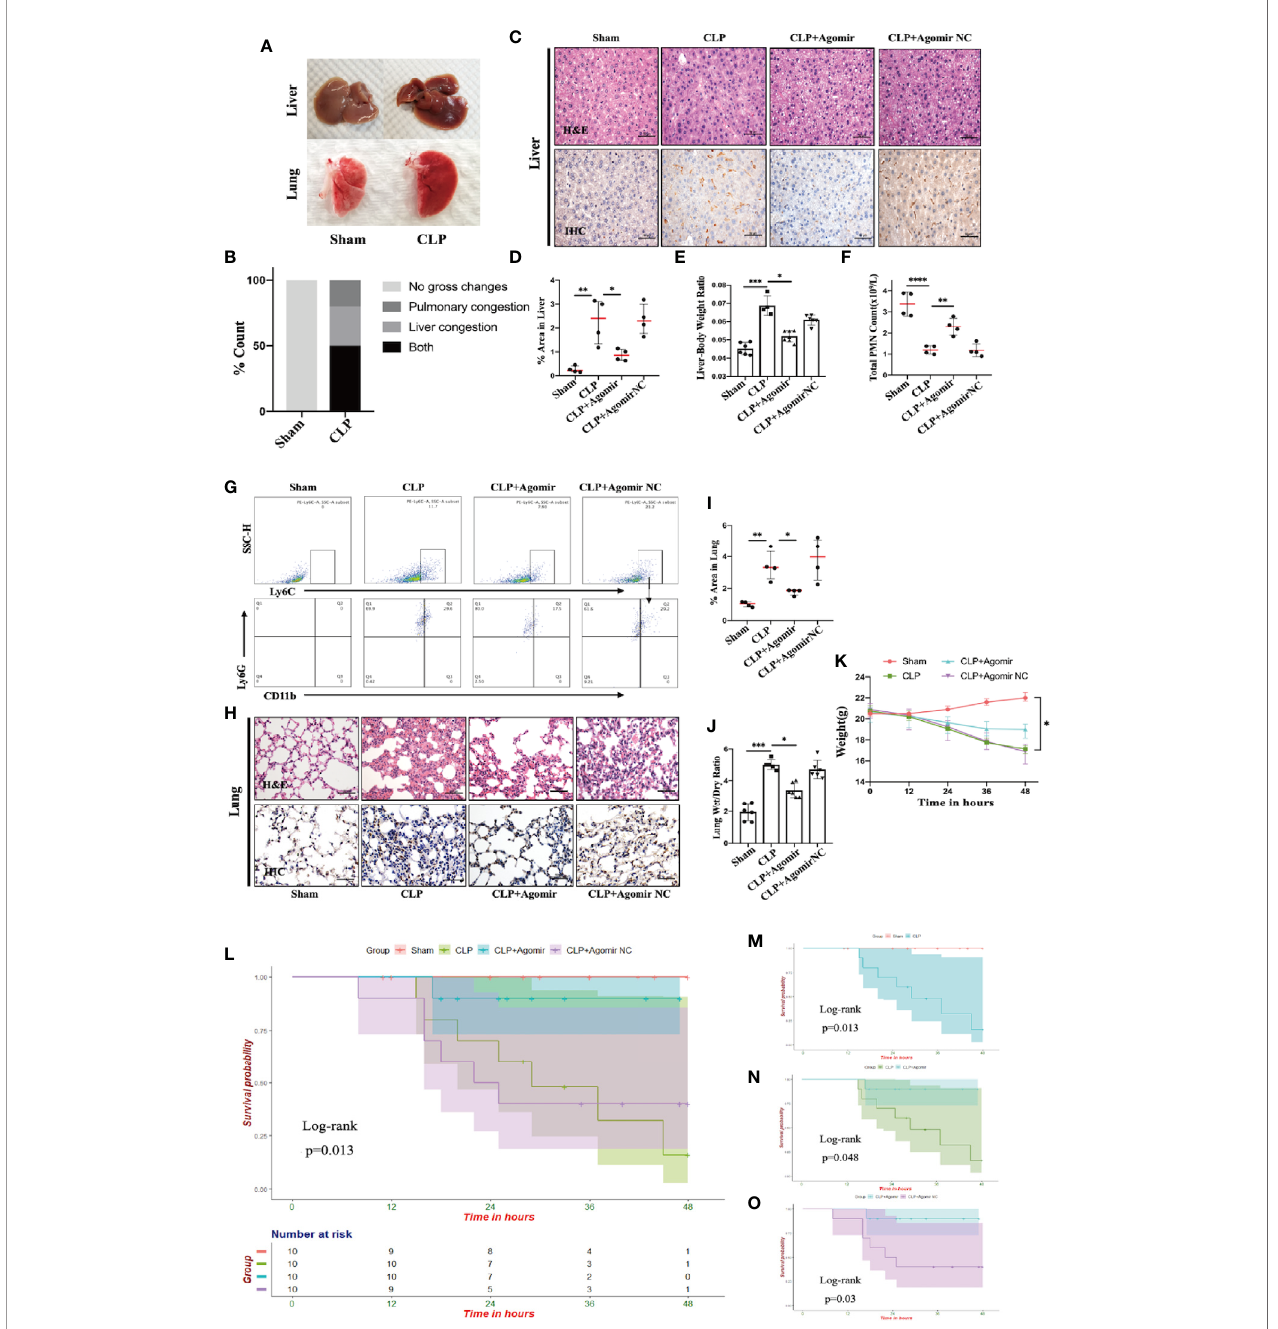
FIGURE 5 | Targeting miR-let-7b alleviates tissueinjury and improves overall survival in CLP murine models. (A, B) Gross pathologic changes in mouse livers and lungs showing pulmonary/liver congestion in sham and CLP-treated mice groups. (C) Histological assessment of livers harvested at 48 hours. Shown are representative H&E stain (upper panel) and IHC images (lower panel). In fi ltratingneutrophils were identi fi ed by CD11b (brown), Scale bars, 50 m m. (D) Area of IHC positive for CD11b expressed as a percentage and assessed in fi ve aleatory images. *P < 0.05; **P < 0.01, one-way ANOVA, n= 4/group. (E) The whole liver was dissected and weighed for determination of liver-body weight ratio (liver to body ratio=liver mass/body mass). n=4 – 7/group. (F) Total neutrophil counts in the blood. **P < 0.01, ****P < 0.0001, one- way ANOVA, n= 4/group. (G) Percentage of neutrophil in fi ltration in mice lung was detected in BALF. Representative fl ow cytometry plots of CD11b+ and Ly6G+ frequency (bottom row) among Ly6Cint cells (top rows). At the end of the experiment (48 h), the lower two-thirds of the right lung weredissected, of which one-third was for lung histology (H, I , same as liver ) and the other one-third was weighed for the lung wet-to-dry weight ratio analyses (J) (n=5 – 6, one-way ANOVA, *P < 0.05, **P < 0.01). (K) The weight of C57BL/6 mice was monitored every 12 hours (*P < 0.05). (L) Survival rate was performed by Kaplan-Meier analysis among four groups. p = 0.013. Survival rates were also performed between sham and CLP group (M) , CLP and CLP+ miR-let-7b agomir group (N) , and CLP + miR-let-7b agomir and CLP + miR-let-7b agomir NC group (O) . n=10 mice/group, Log-rank test, p = 0.013, p = 0.048 and p = 0.03,